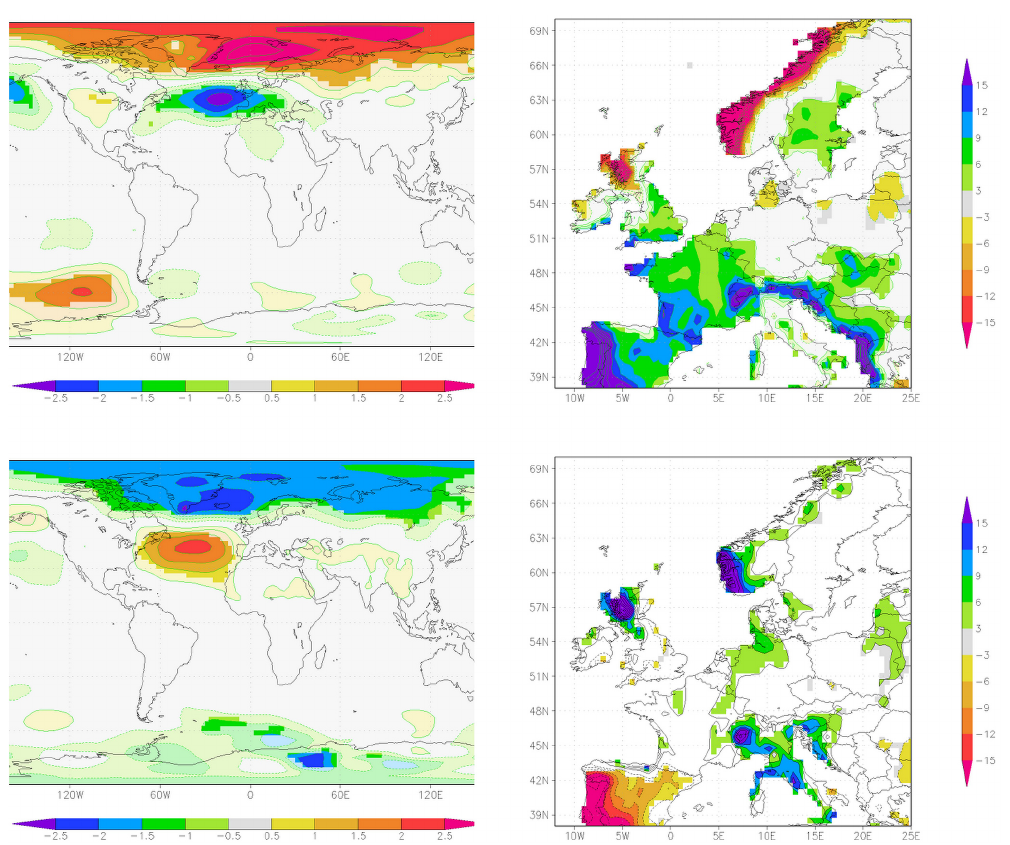
Figure 9. Top left panel: near-global PMSL anomalies (hPa) in winter half-years for most easterly QBO 15% of 30hPa equatorial strato- spheric winds (1953–1954 to 2012–2013). Top right panel: rainfall anomalies for the top 15% most easterly of all equatorial stratospheric winds. Bottom left panel: as top left but for the 15% most westerly QBO winds. Bottom right panel: as top right panel, but for the 15% most westerly winds. Areas significant at the 5% level are dark coloured. PMSL is from the NCEP